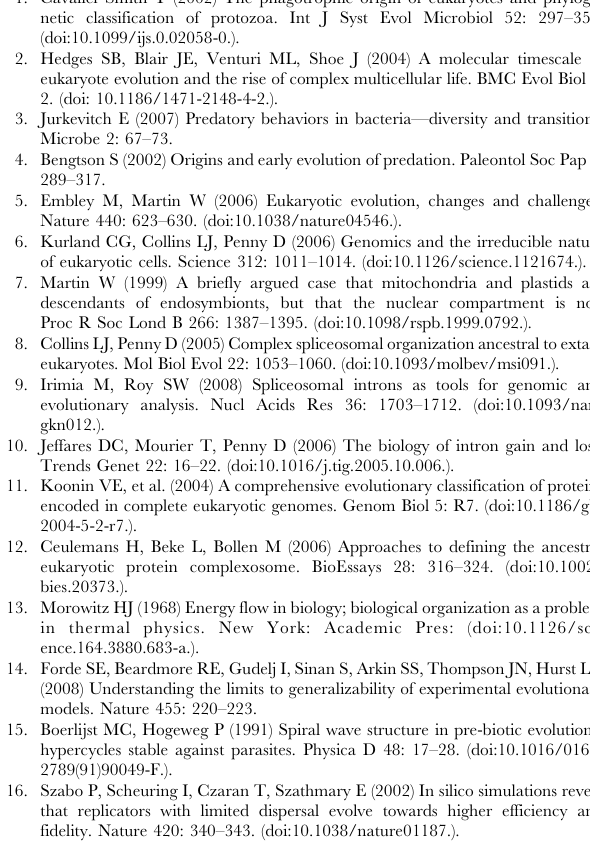
Figure S3 Development of total number of unicells with limited food supply and no carnivory. This shows that exponential growth stops after a while, ending with an overshoot and then reaching a stationary distribution with stochastic variations. Conditions are the same as in Figure 2, but the amount of food added is according to the standard situation of table S2 (it is therefore only 10% of that in figure